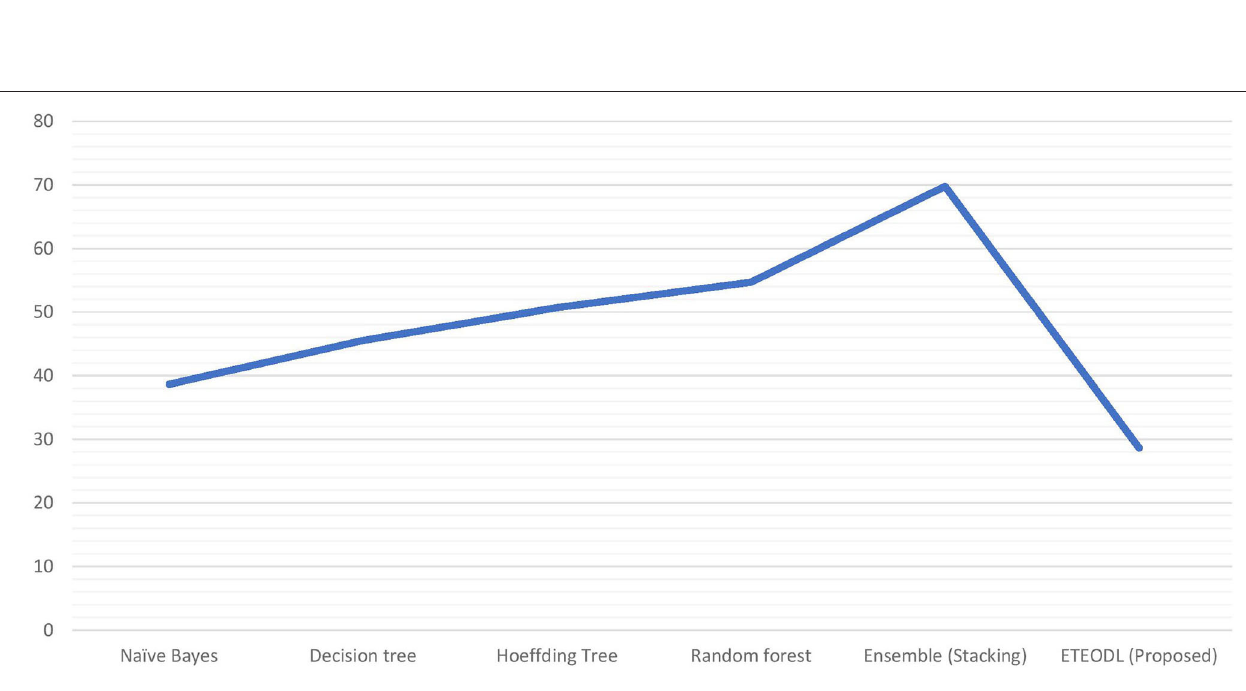
FIGURE 3 | Comparison of computation time (in